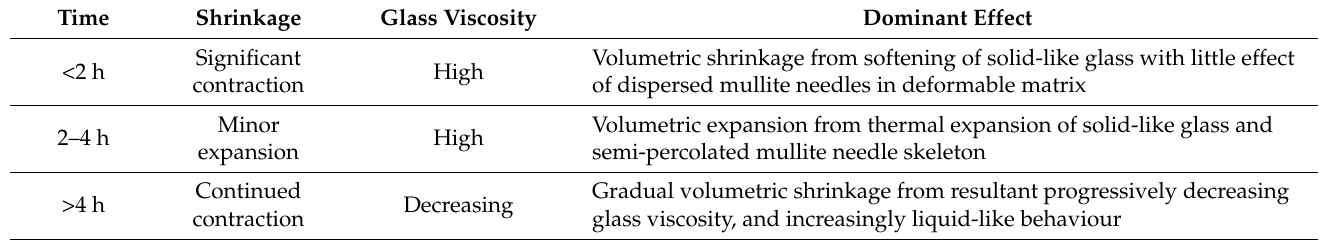
Table 3. Interpretation of volumetric shrinkage prior to percolation exhibited in Figure